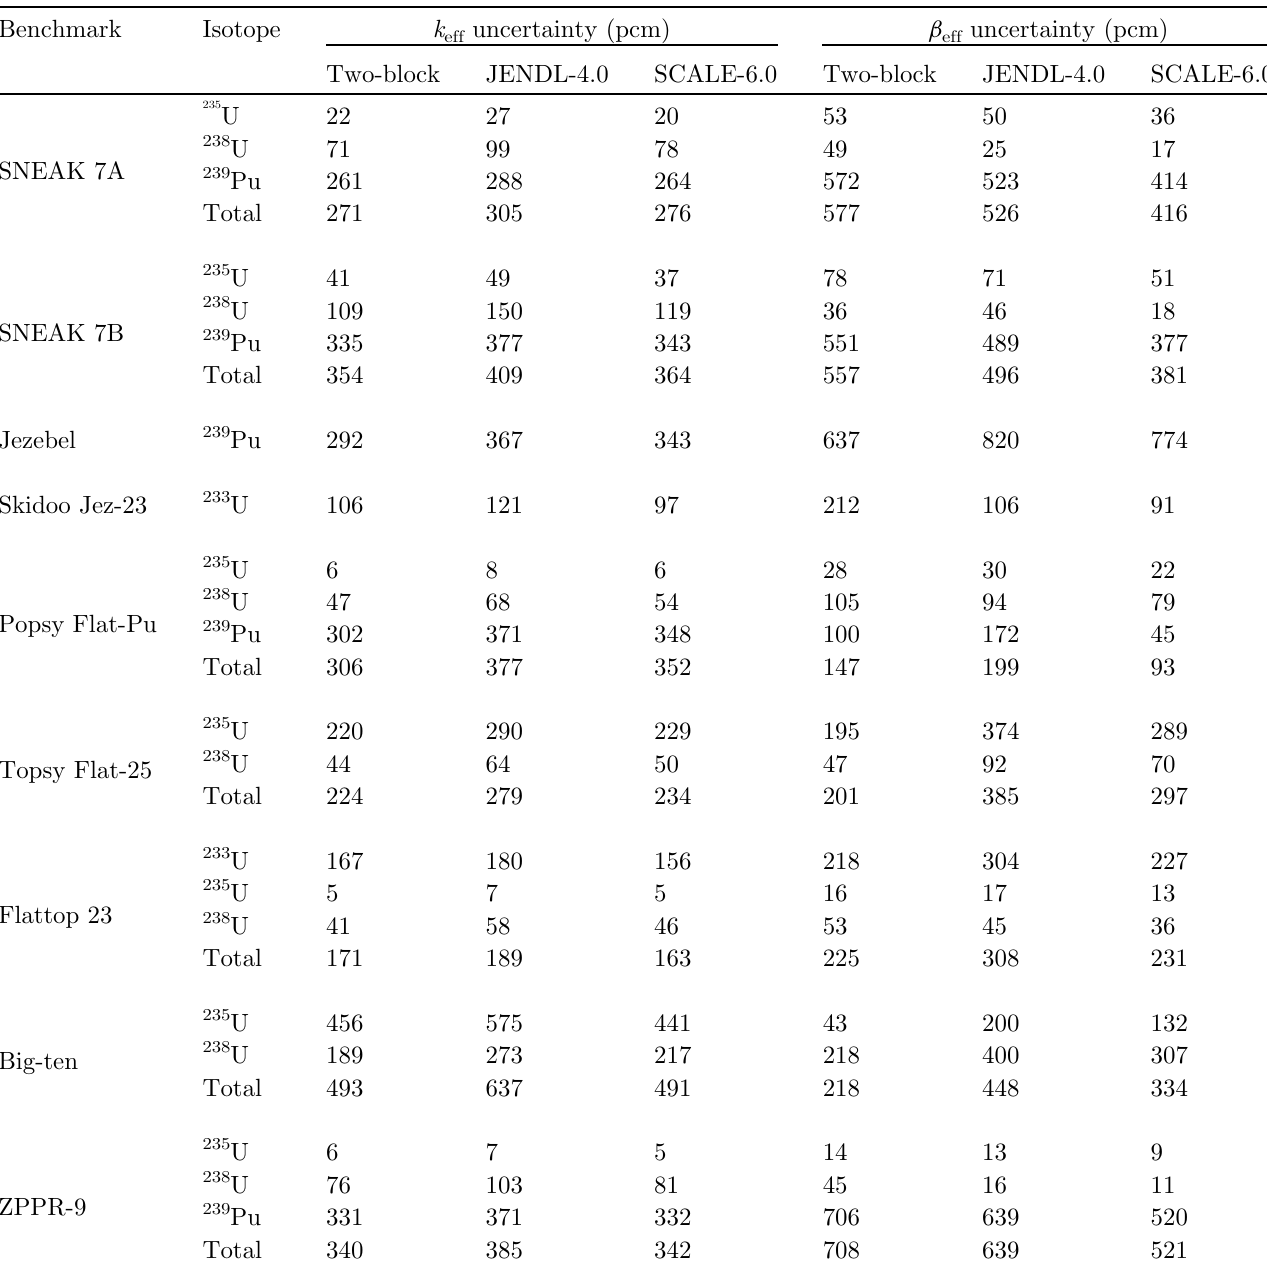
Table 4. Fission spectra uncertainties in k neutron spectra covariances (i.e. assuming fl at anti-correlated 4% standard deviation) compared to those based on covariances from JENDL-4.0 and